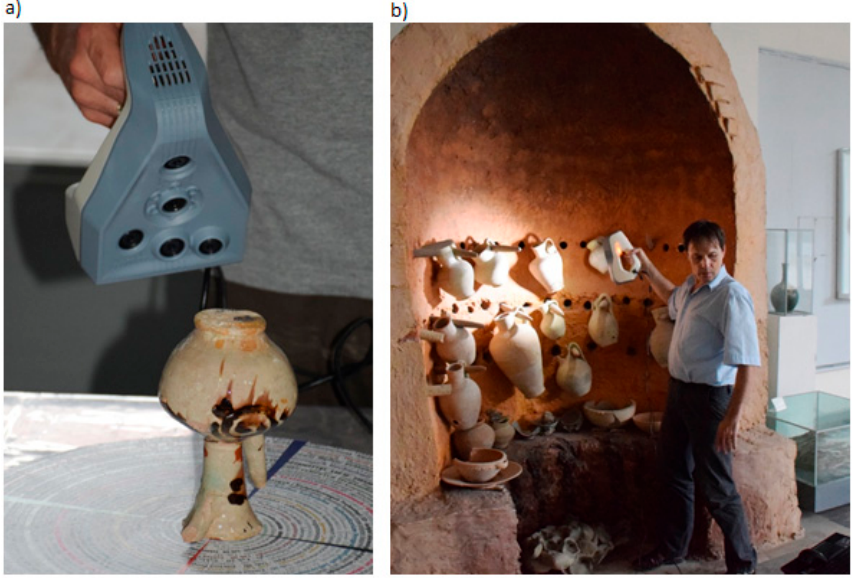
Figure 4. Scanning objects with SLS: ( a ) jug—Artec Spider, ( b ) model of kiln—Artec Eva. Artec Studio software version 15 Professional and a computer equipped with an Intel Core i7 (3.4 GHz) processor, 64 GB RAM and an NVIDIA GeForce GTX 1080 graphics card with 8 GB internal memory were used to process the data obtained in the process of scanning the jug and stove. The stages of data processing in the form of 3D SLS point clouds on the example of a jug are shown in Figure 5.